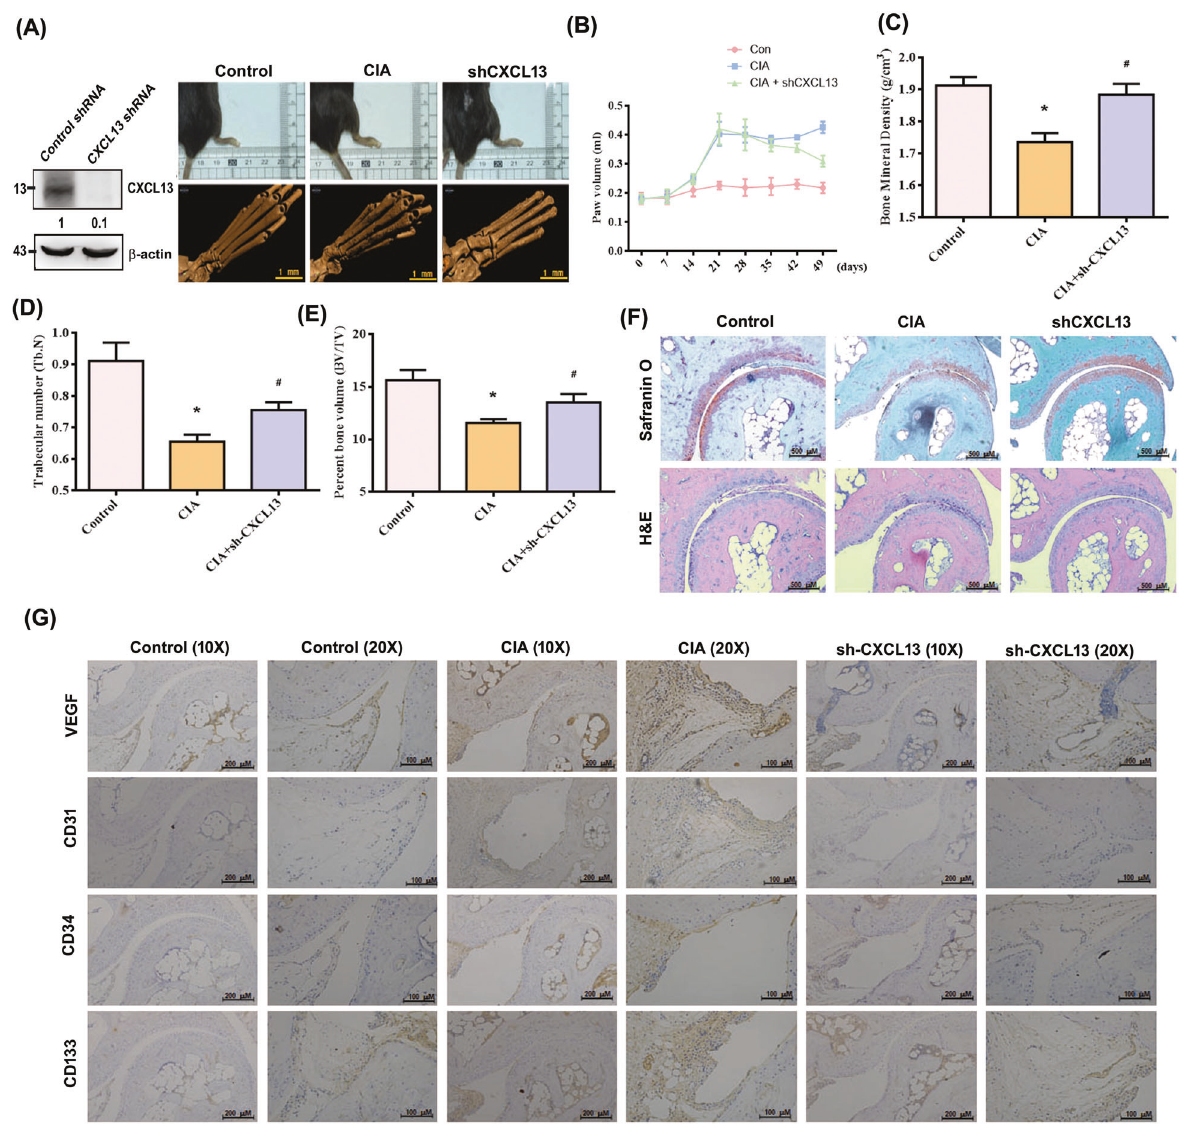
Fig. 7 CXCL13 knockdown reduces EPC homing and angiogenesis as well as the severity of RA in vivo. CIA mice received intra-articular injections of 7.1 × 10 6 PFU CXCL13 shRNA ( n = 6) or control shRNA ( n = 6) on day 14 and were euthanized on day 49. A Representative micro- CT image of the hind paws was taken on day 49. B A digital plethysmometer quanti fi ed the amounts of hind paw swelling. C – E Micro-CT SkyScan Software quanti fi ed BMD, trabecular numbers, and bone volume ( n = 6). F and G Histological sections of ankle joints were stained with H&E or Safranin O and immunostained with VEGF, CD31, CD34, and CD133 ( n = 6). * p < 0.05 versus the control group; # p < 0.05 versus the CXCL13-treated